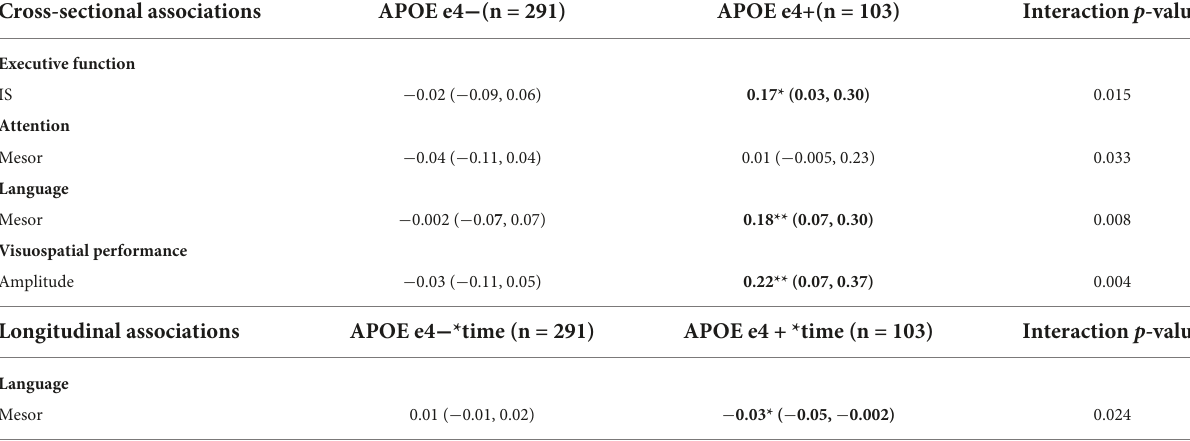
TABLE 14 APOE e4 carrier status: significant cross-sectional and longitudinal interactions with CRARs on cognition, beta estimate (95% CI). Cross-sectional